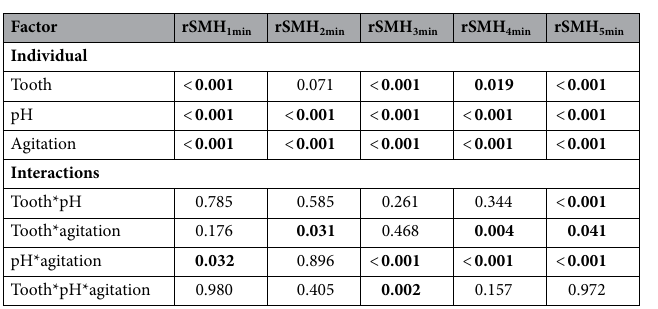
Table 1. Significance values for the impact of individual factors, as well as their interaction, on the relative surface microhardness (rSMH) at each erosion time (1–5 min). Significant values are in [bold].